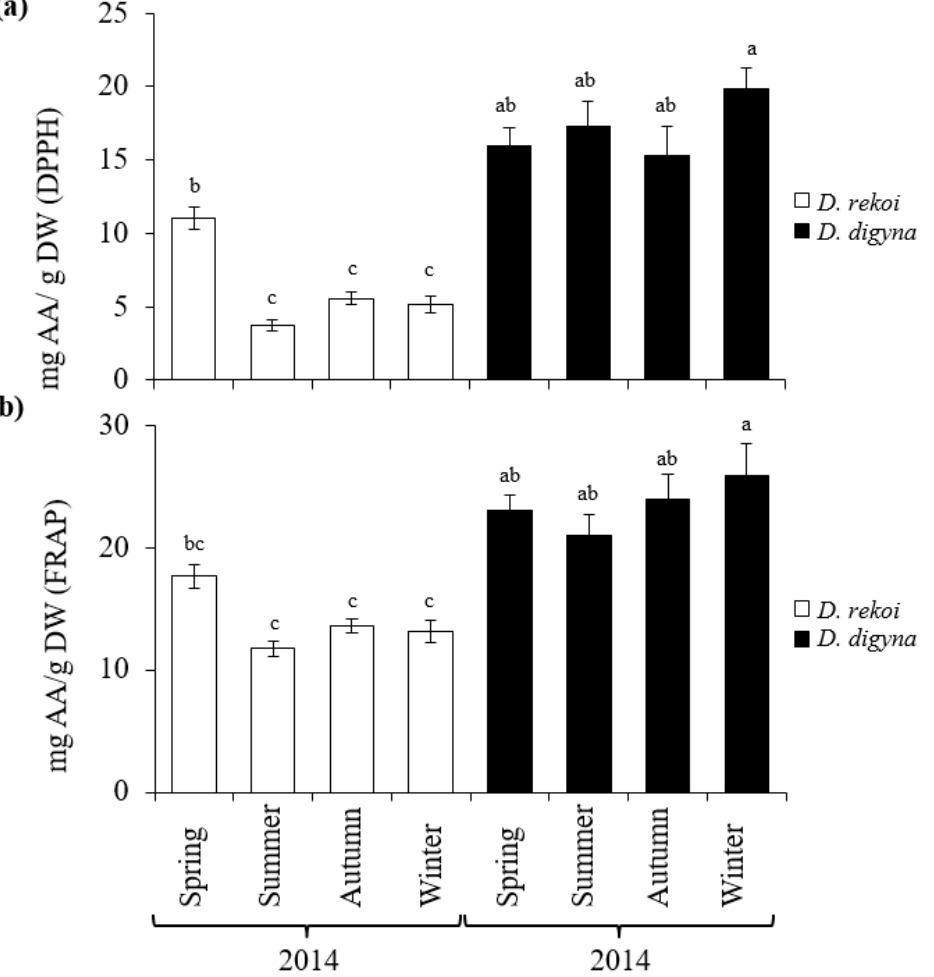
Figure 5. Average seasonal variation in antioxidant activities in aqueous methanol leaf extracts sampled from Diospyros digyna and D. rekoi trees. Antioxidant activity was measured using the ( a ) DPPH (2, 2 (cid:48) -diphenyl-1-picrylhydrazyl) and ( b ) FRAP (ferric ion-reducing antioxidant power) assays. Both were expressed as ascorbic acid (AA) equivalents. The bars represent the mean values obtained from leaf extracts produced from the pooled leaves of five trees sampled in the spring, summer, and autumn, and winter of 2014, respectively. Intervals over the bars represent the standard error of the means, whereas di ff erent letters over the bars represent statistically di ff erent values at p ≤ 0.05 (Tukey–Kramer test). DW = dry